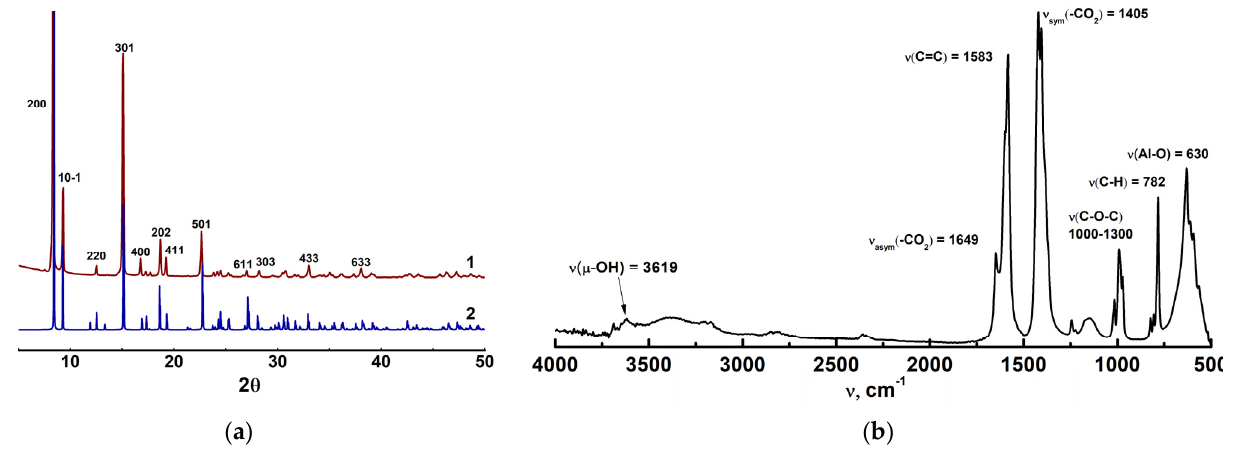
Figure 3. XRD patterns ( a ) of the synthesized MIL-160 (2) and the curve calculated from CIF-file (1); FT-IR spectra ( b ) of MIL-160.